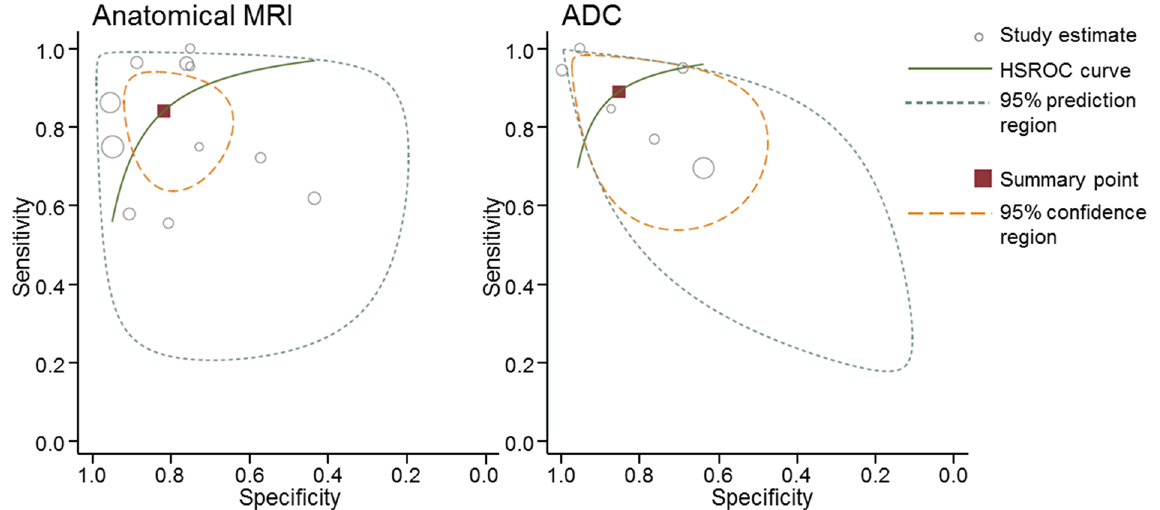
Fig 3. Hierarchical summaryreceiveroperator curves of anatomical MRI and ADC for the primary tumor